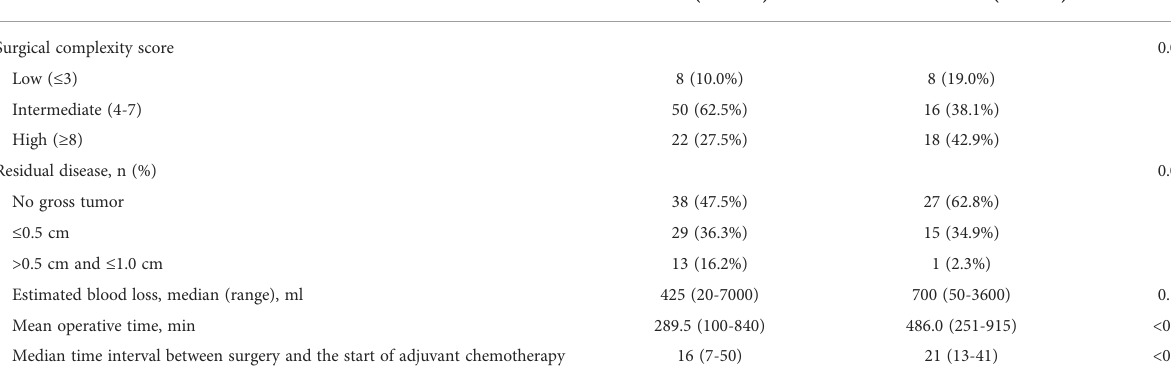
TABLE 2 Surgical characteristics.